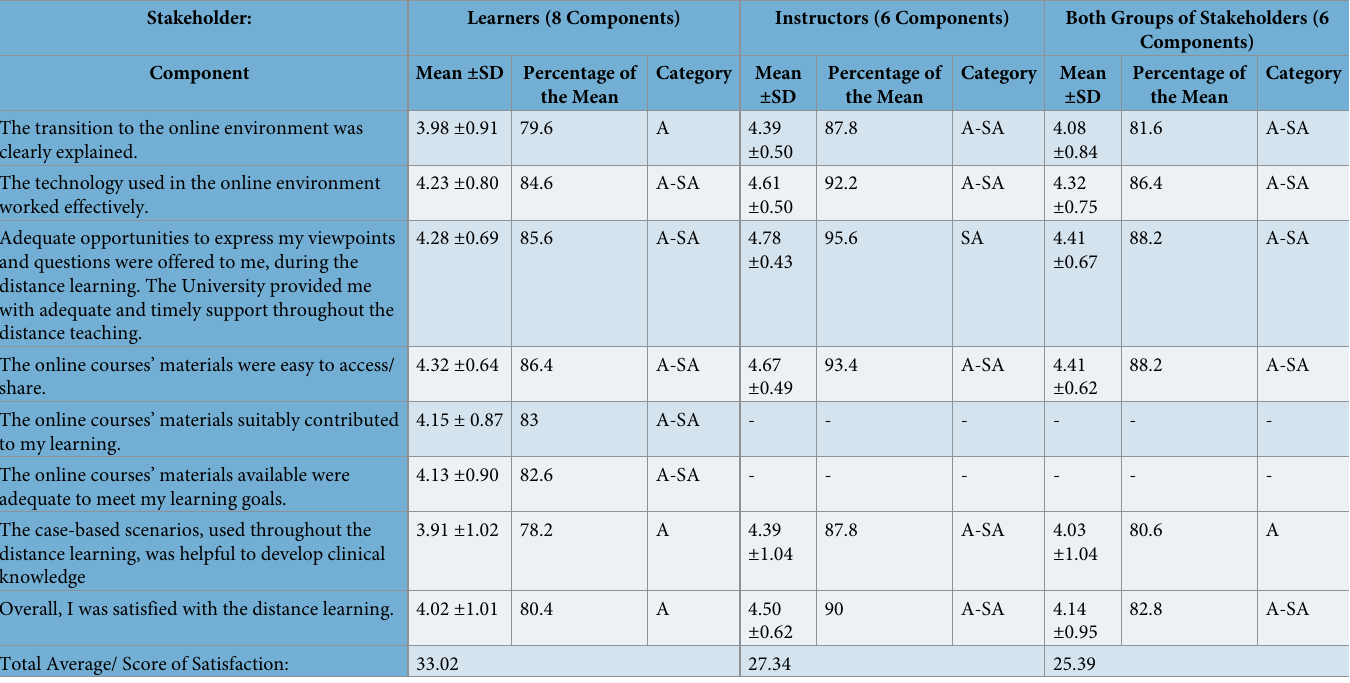
Table 2. Output of descriptive quantitative analysis.